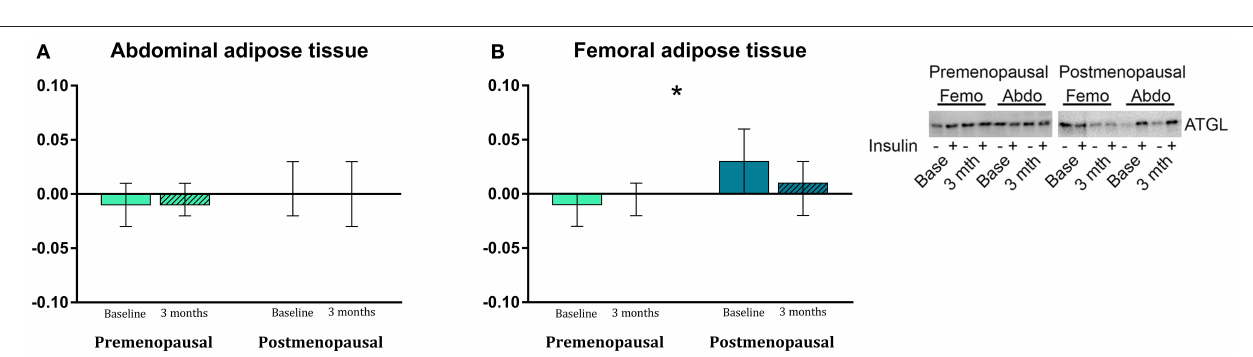
FIGURE 6 | The effect of 120min of hyper insulin stimulation on protein abundance of ATGL (delta value, arbitrary units) in abdominal (A) and femoral (B) adipose tissue in pre- and post-menopausal women before and after 3 months of high-intensity training. Insulin stimulation suppressed ATGL in femoral subcutaneous adipose tissue in pre- but not in post-menopausal women. Difference between groups * p ≤ 0.05. Data are presented as mean (95% confidence limits). ATGL, Adipose triglyceride lipase.